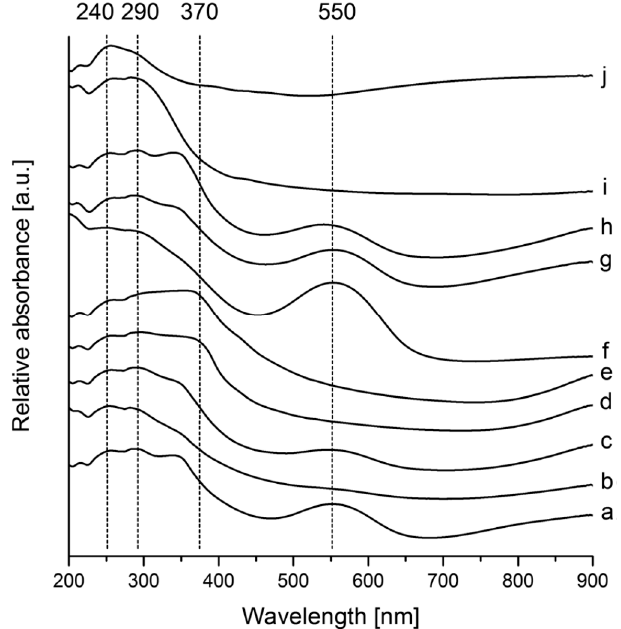
Figure 3. Solid-state UV-visible spectra of as-prepared Fe-SAPO-34 obtained using (a) DETA, (b) HEEDA, (c) TETA, (d) 232, (e) 323 and (f) TEPA (all with Fe 2+ ); (g) TEPA with Fe 3+ , (h) PEHA (with Fe 2+ ), (i) morpholine (with Fe 3+ ) and (j) TEA + (with Fe 2+ ). Reprinted with permission from [38].